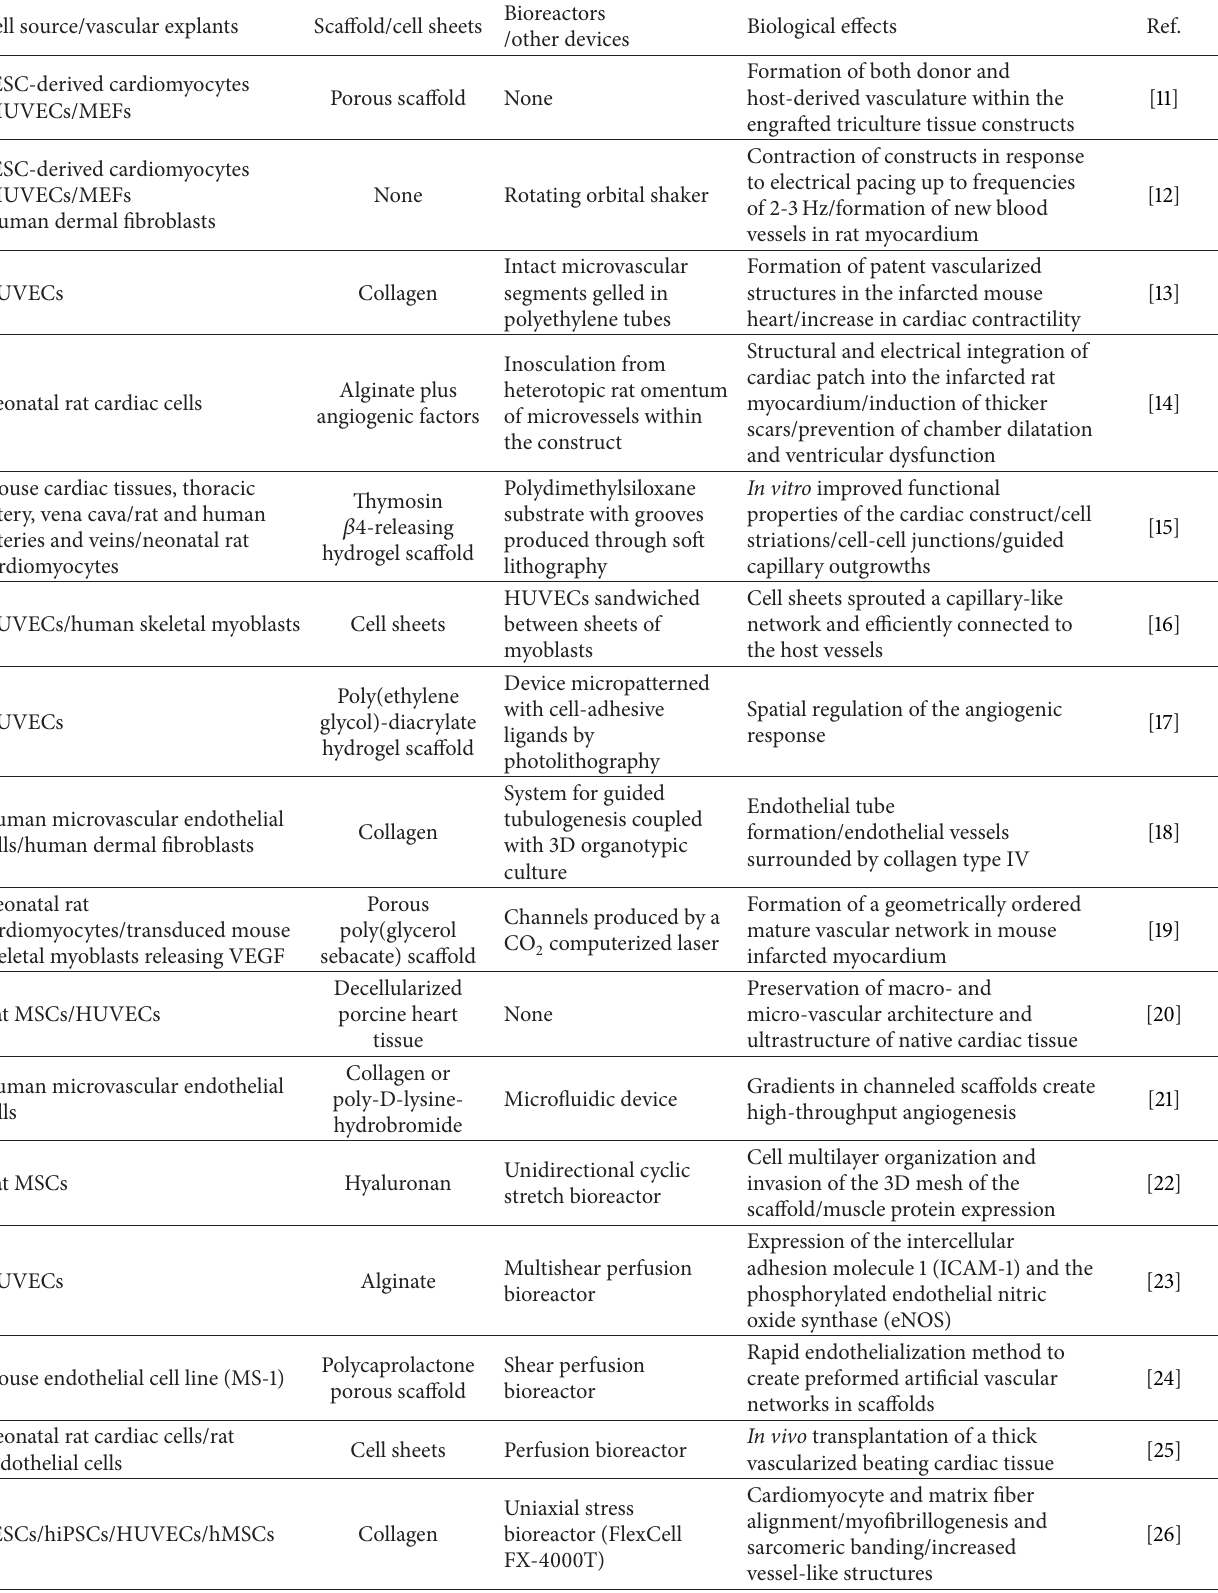
Table 1: Strategies to promote functional vascularization of cardiac